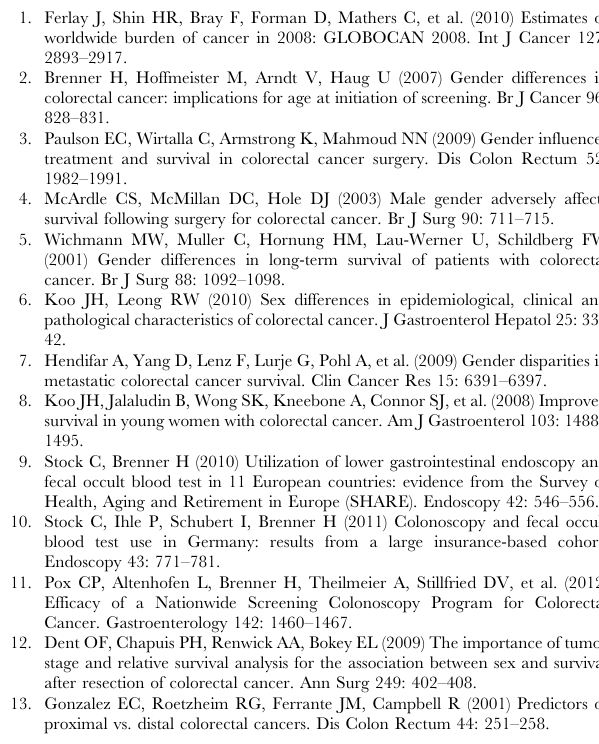
Table S1 Estimates of regression coefficients and respective relative excess risk (RER) in multivariate model adjusting for age, stage and subsite, including interaction of sex with age and sex with stage. Table S2 Estimates of regression coefficients and respective relative excess risk (RER) in multivariate model adjusting for age, stage and subsite, including interaction of sex with age and sex with